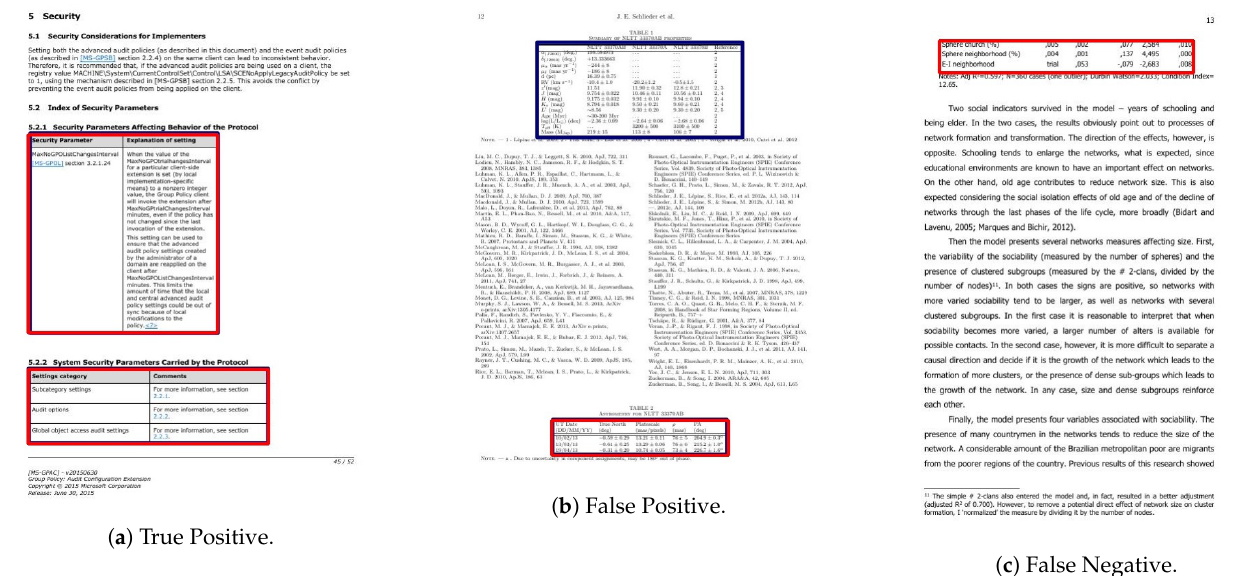
( c ) False Negative. ( b ) False Positive. ( a ) True Positive. Figure 7. HybridTabNet results on TableBank Word dataset. ( a – c ) True positive, False positive, and False negative results, respectively. The blue outline shows the predicted table, and the red outline highlights the ground truth table.